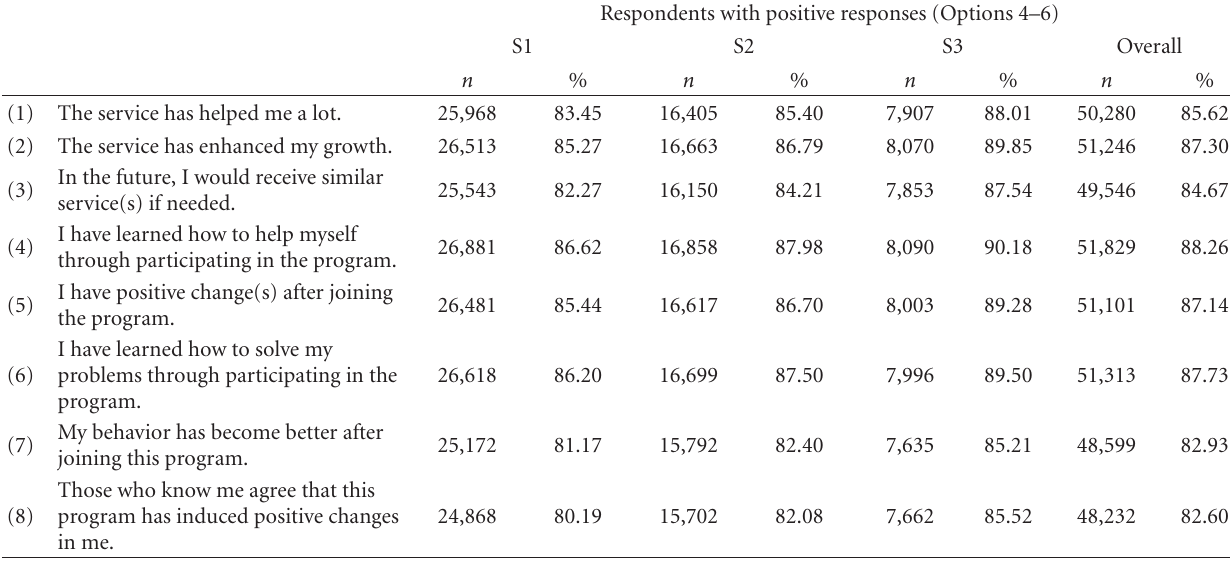
Table 5: Summary of the students’ perception towards the program e ff